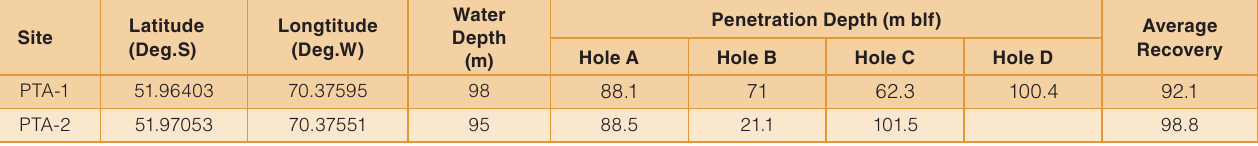
Table 1. Location of drill sites, water and penetration depths as well as core recovery rate Latitude Site (Deg.S)